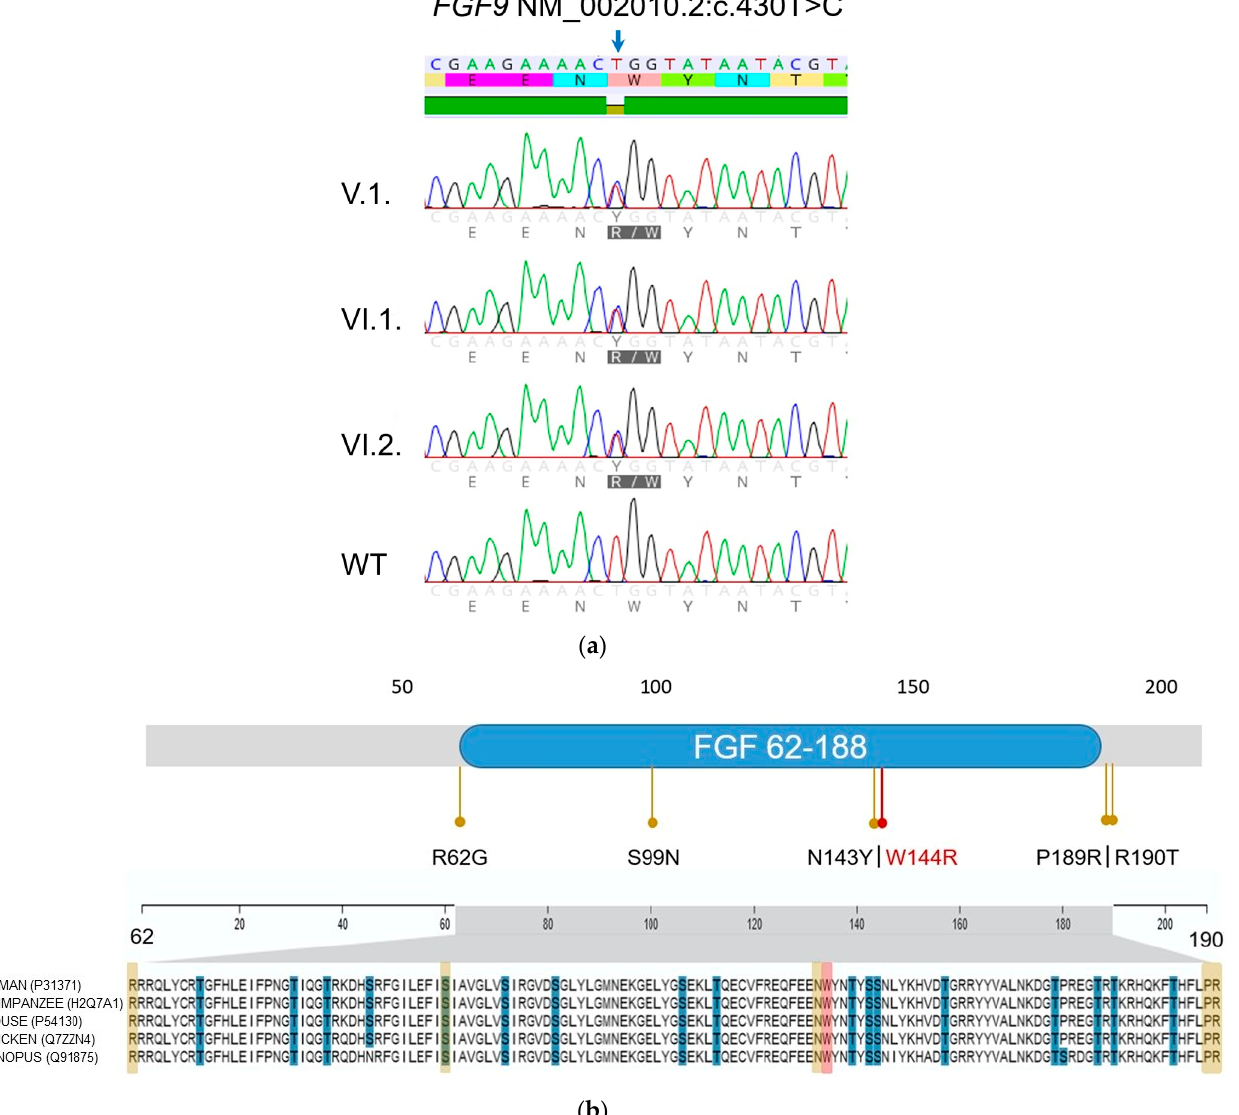
Figure 5. ( a ) Sanger chromatogram of the FGF variant c.430T>C in patients VI.1., VI.2., V.1. and wild-type allele (WT). ( b ) Upper-row protein domain structure of FGF9 , with the known missense variants causing SYNS3 marked by yellow dots and the variant in this report (W144R) marked in red. Lower-row protein sequence alignment down to Xenopus; note the highly conserved amino acid sequence (this figure was partially build upon material from UniProt [22] licenced under CC BY 4.0 (https://creativecommons.org/licenses/by/4.0/)).